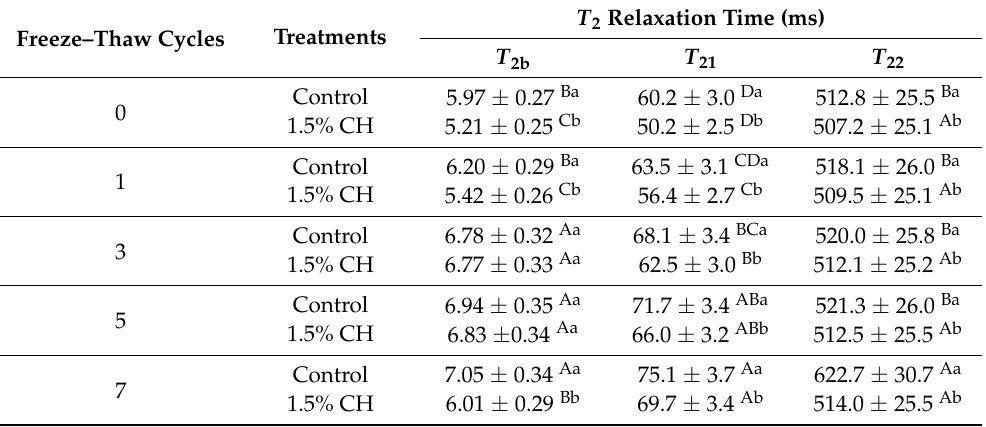
Table 4. Influence of chitosan ice coating on the T 2 relaxation times of fish balls induced by freeze– thaw cycles.